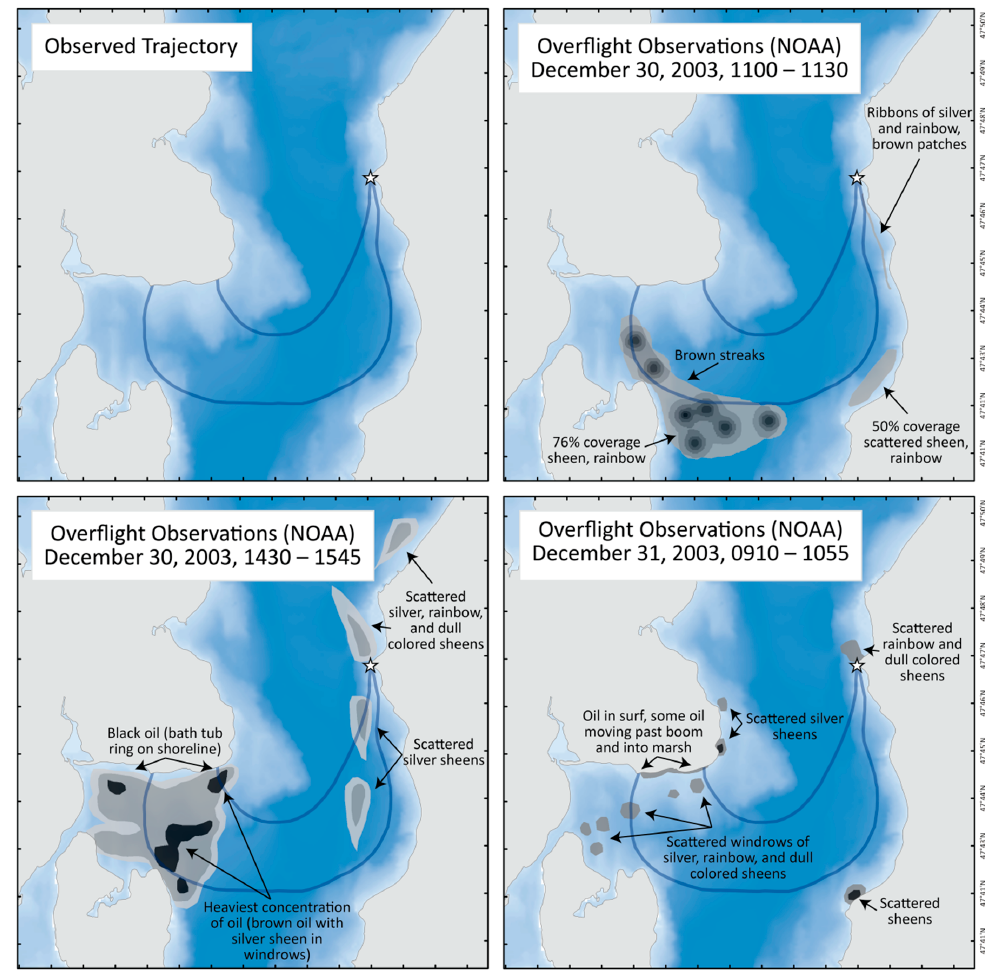
Figure 4. A schematic of the observed oil path (top left), and a time series of digitized maps from National Oceanic and Atmospheric Administration’s (NOAA’s) overflight observation records.